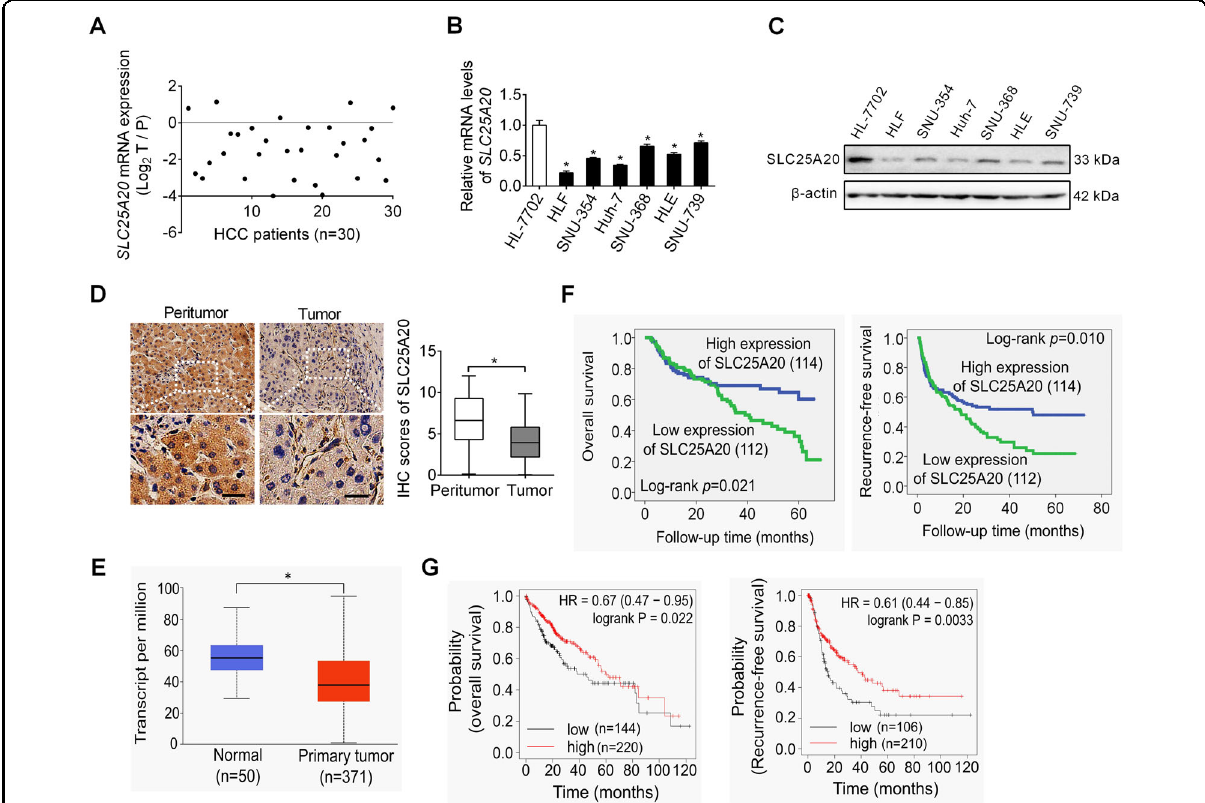
B , C SLC25A20 expression was determined in six HCC cell lines and one hepatocyte by using qRT – PCR and Western blot analysis. D Protein-expression levels of SLC25A20 were determined in 226-paired tumor and peritumor tissues of HCC using immunohistochemical (IHC) staining analysis. Scale bar, 20 μ m. E Bioinformatics analysis for SLC25A20 expression at mRNA based on the online web portal UALCAN (http://ualcan.path.uab.edu). F Prognostic signi fi cance of SLC25A20 with Kaplan – Meier curves analysis based on the IHC analysis results in 226 patients with HCC. G Prognostic signi fi cance of SLC25A20 with Kaplan – Meier curves analysis based on the online web portal Kaplan – Meier Plotter in patients with